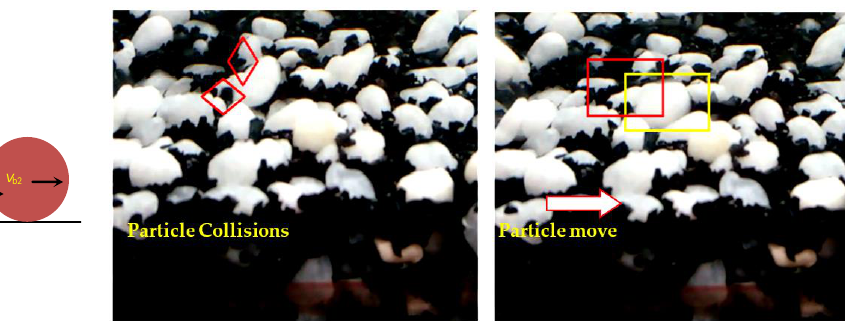
Figure 15. Sketch of the particle-collision process and experimental evidence. The sketch shows how the momentum transfer happens when a fine particle collides with a coarse particle, where the dashed red line indicates the turbulent flow intensity. Thus, several collisions from the fine particles cause the coarse particle to move (moved from the location marked by the red box to the location of the yellow box), as shown in the photos on the right.